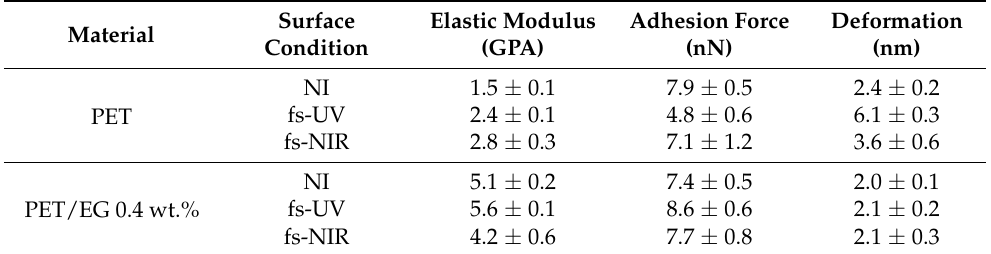
Table 4. Elastic modulus, adhesion force, and deformation of non-irradiated (NI) and irradiated (fs UV and fs NIR pulses) on PET and PET/EG 0.4 wt.% surfaces, obtained by PF-QNM-AFM technique. The data listed correspond to the average and standard deviation of three different